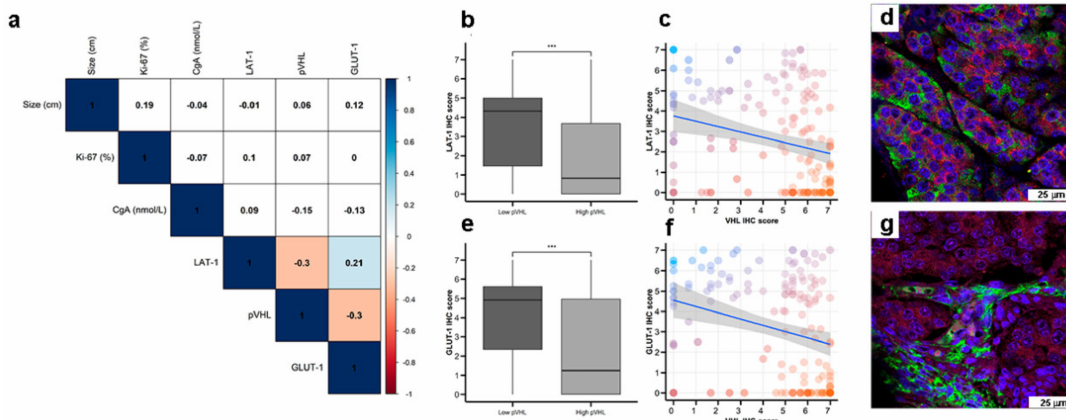
Figure 3. Co-expression of nutrient transport markers and VHL in GEP-NETs. LAT-1, GLUT-1, and pVHL were measured by IHC in a set of TMAs ( n = 164) from GEP-NETs, including primary and metastatic tissue. ( a ) Correlation map of hypoxia marker expression in TMAs with tumor size and Ki67 and Chromogranin A (CgA). Values represent the Spearman’s rank correlation coe ffi cient, rho ( (cid:37) ). Significant negative correlations are shown in orange and significant positive correlations in blue. Color intensity increases with the magnitude of correlation. White indicates non-significant correlation. ( b ) Boxplot of LAT-1 IHC scores in low and high pVHL tumor tissues. ( c ) Scatter plot of LAT-1 and pVHL (regression line is represented with confidence interval). ( d ) Double immunofluorescence with LAT-1 (green) and pVHL (red) in intestinal tumor tissue. ( e ) Boxplot of GLUT-1 IHC scores in low and high pVHL tumor tissues. ( f ) Scatter plot of GLUT-1 and pVHL (regression line is represented with confidence interval). ( g ) Double immunofluorescence was performed with GLUT-1 (green) and pVHL (red) in intestinal tumor tissue. Scale bar for 75 µ m is represented with a white box for each panel. Boxplots visualize five statistics (the median, first quartile, third quartile, and two whiskers). The upper and lower hinges correspond to the third (75th percentile) and first (25th percentile) quartiles. The upper whisker extends from the hinge to the largest value no further than 1.5 fold the interquartile range (IQR) of the hinge. The lower whisker extends from the hinge to the smallest value at most 1.5 fold the IQR of the hinge. Asterisks indicate significant di ff erences between tumor and peritumoral tissues (*** p <